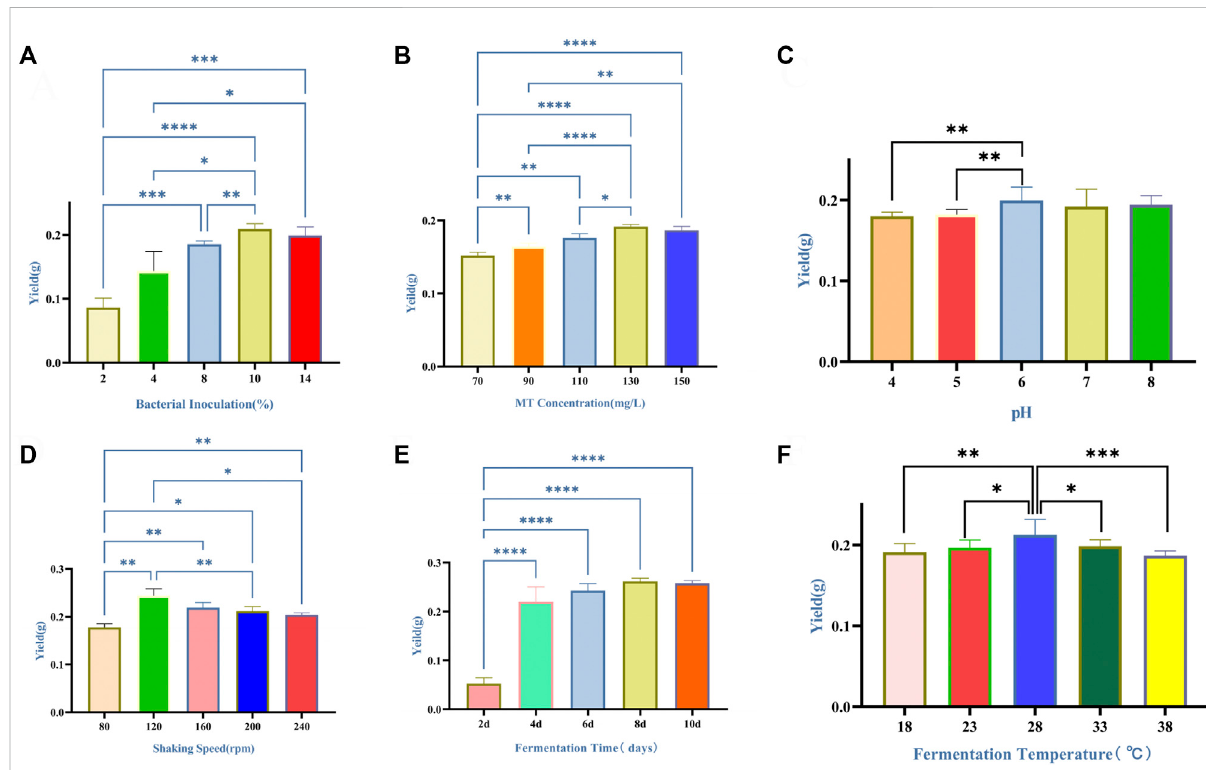
FIGURE 1 Effects of six fermentation factors on production of the yield of dry mycelium of Marsdenia tenacissima with Ganoderma lucidum co- fermentation (A – F) . Data were expressed as means ± SD (n = 6). * p ≤ 0.05; ** p ≤ 0.01; *** p ≤ 0.001; **** p ≤ 0.0001. (A) Bacterial inoculation. (B) MT concentration. Data versus 70 mg/L of MT concentration. (C) pH. (D) Shaking speed. (E) Temperature. (F) Fermentation